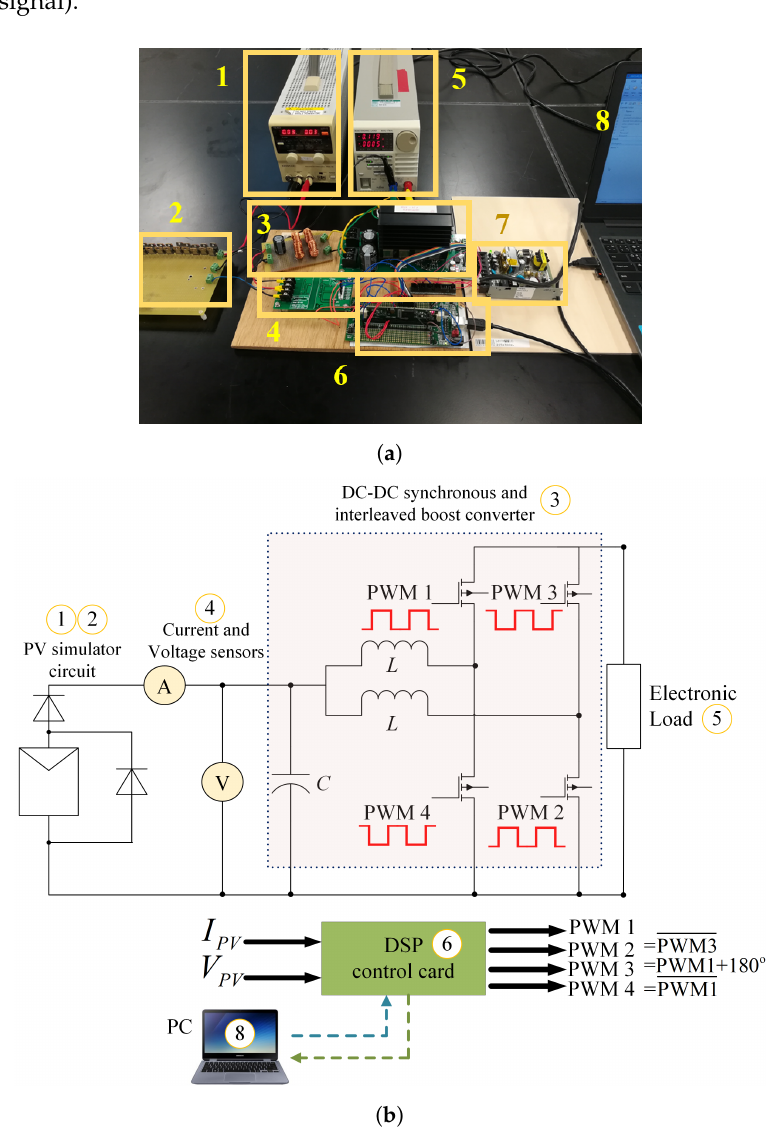
Figure 13. ( a ) Photograph of the experimental system. ( b ) Diagram of the experimental